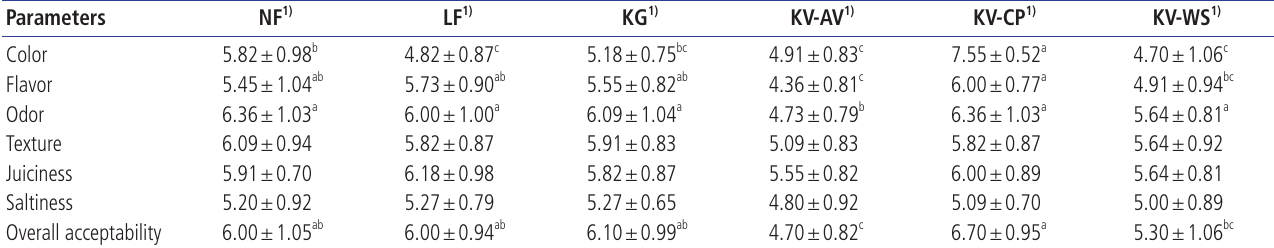
Table 7. Sensory properties of frankfurter sausages